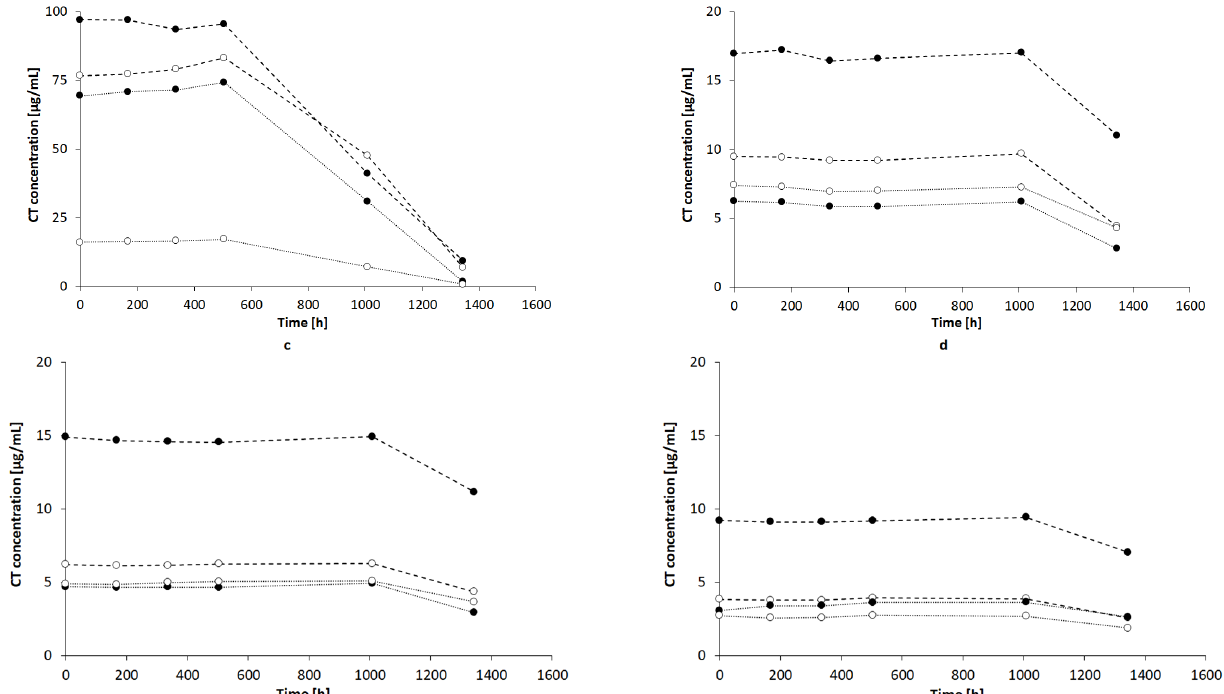
Figure 7. CT concentrations in: ( a ) NaOH solutions of 1 mol/L (- • -), 0.1 mol/L (- ◦ -), 0.01 mol/L (.. • ..), and 0.001 mol/L (.. ◦ ..) and in 1% alcoholamine solutions of AMPD (- • -), TRIS (- ◦ -), TEOA (.. • ..), and TIPA (.. ◦ ..) prepared at temperatures of 60 °C ( b ), 50 °C ( c ), and 40 °C ( d ). The lines are guides for the eye.